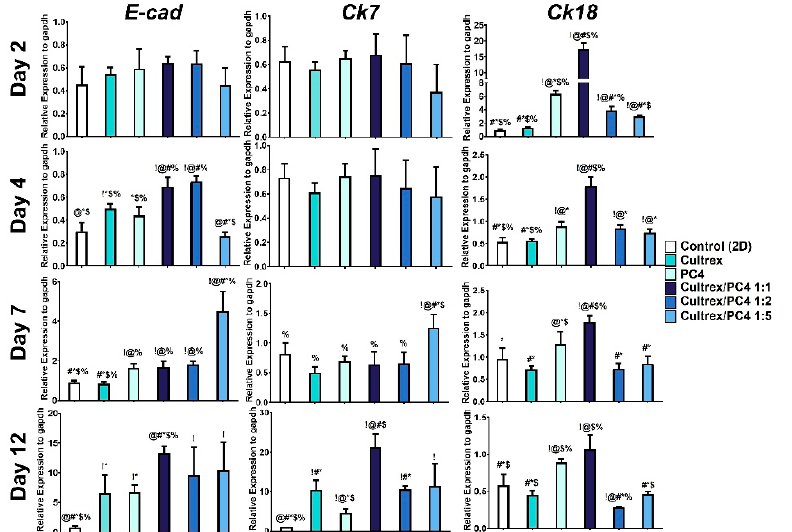
Figure 7. Gene expression of hepatobiliary progenitor markers ( E-cad, Ck7 , and Ck18 ). After HepG2 cells were cultured in different conditions from day 2 to 12, the mRNA expression profile was determined by qPCR. ! indicates groups compared with control (2D). @ indicates groups compared with Cultrex. # indicates groups compared with PC4. * indicates groups compared with Cultrex/PC4 1:1. $ indicates groups compared with Cultrex/PC4 1:2. % indicates groups compared with Cultrex/PC4 1:5. The results from the three independent experiments are presented as the mean ± standard deviation. !, @, #, *, $, % p < 0.05.